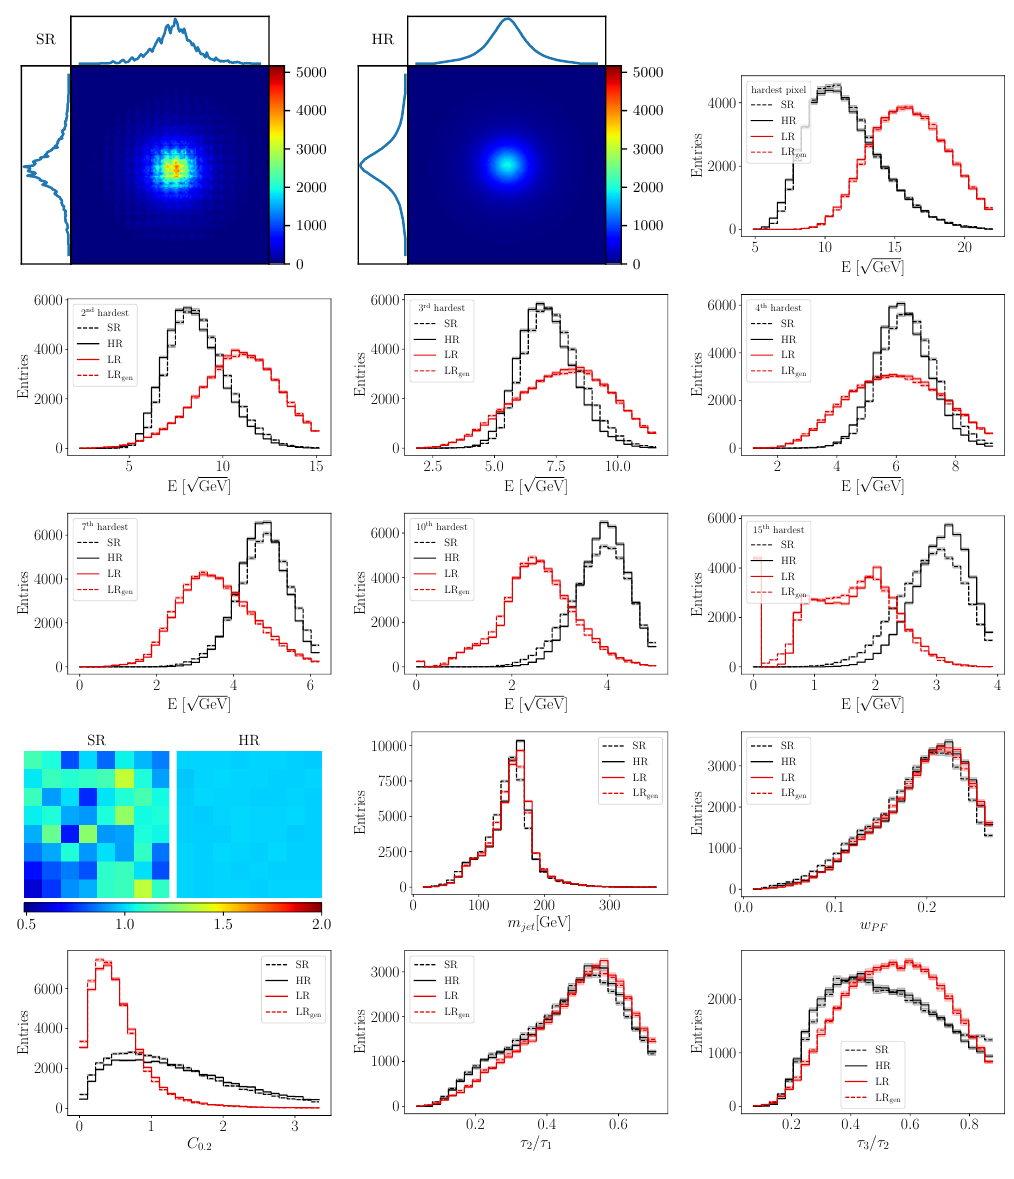
Figure 5: Demonstration of the performance of a network trained on top-quark jets and applied to top-quark jets. Top left are averages of the HR and SR images, fol- lowed by distributions of the square-root of the energy of leading pixels, sub-leading, etc. Also shown are average ( f × f )-patches for the SR and the HR images, and distri- butions of high-level jet observables, see text for definitions. The zero-bin in energy collects jets with too few